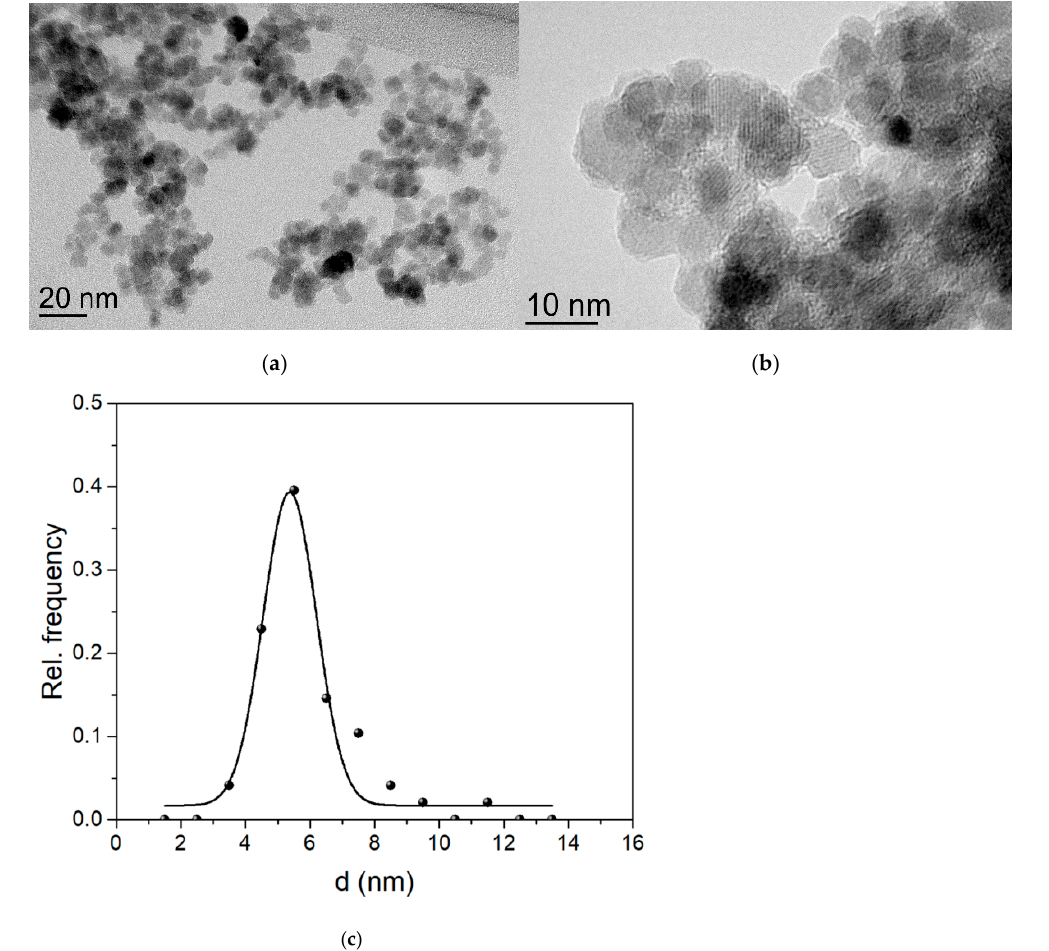
Figure 5. ( a , b ) TEM images of Fe 3 O 4 @CA MNPs; ( c ) corresponding NP size distribution from the